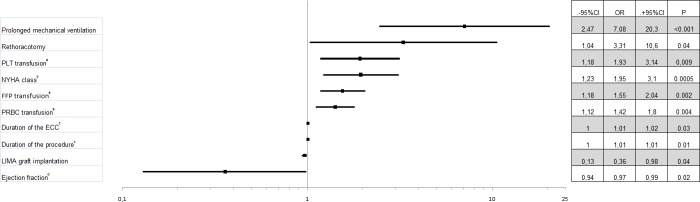
Factors influencing on in-hospital mortality.a—for every next transfused unit, b—for next higher class, c—for every next 10 min, d—for every 1% increase in left ventricular ejection fraction. Abbreviations: PLT, platelet concentrate; NYHA, New York Heart Association; FFP, fresh frozen plasma; PRBC, packed red blood cells; ECC, extracorporeal circulation; LIMA, left internal mammary artery.